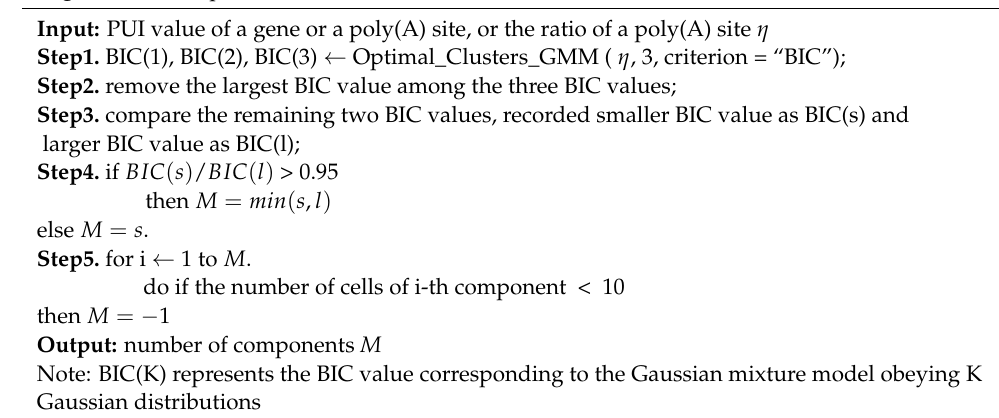
Algorithm 1 The pseudocode of